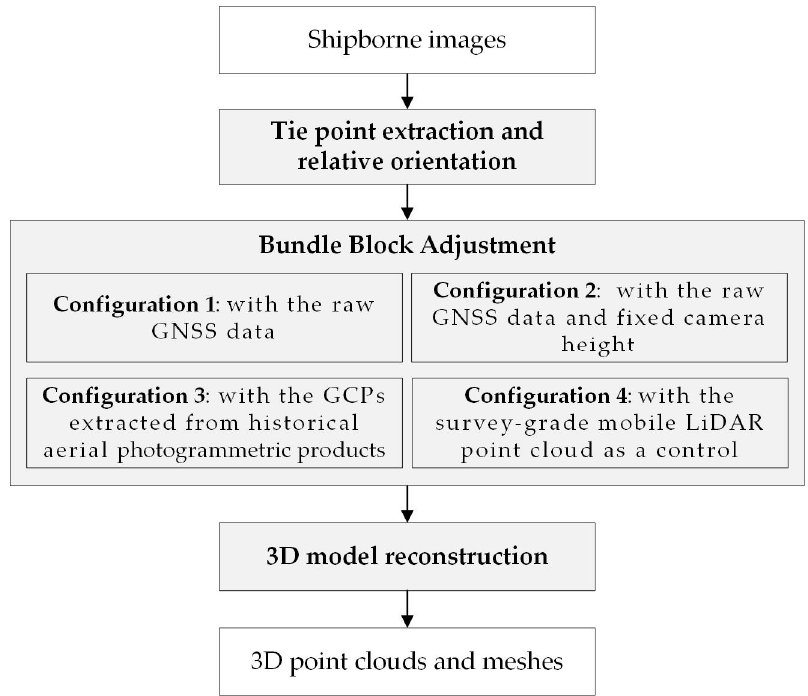
Figure 6. Flowchart of shipborne image processing.